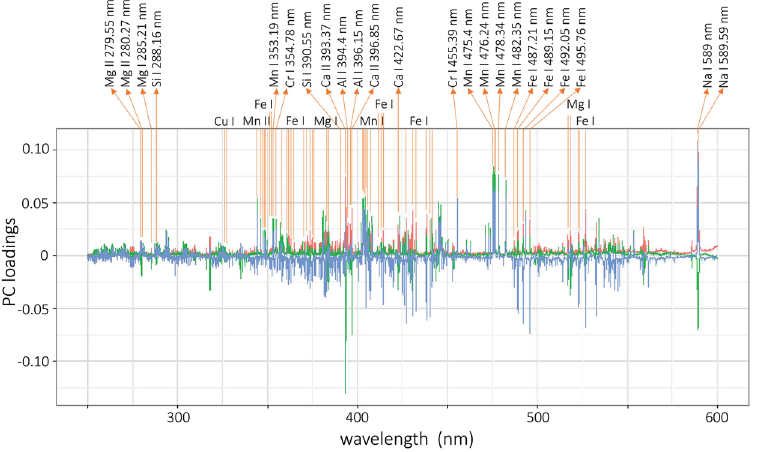
Figure 5. PCA analysis yielded from sedimentary ore CRM LIBS data: loadings, where PC1 is red, PC2 is green and PC3 is blue.